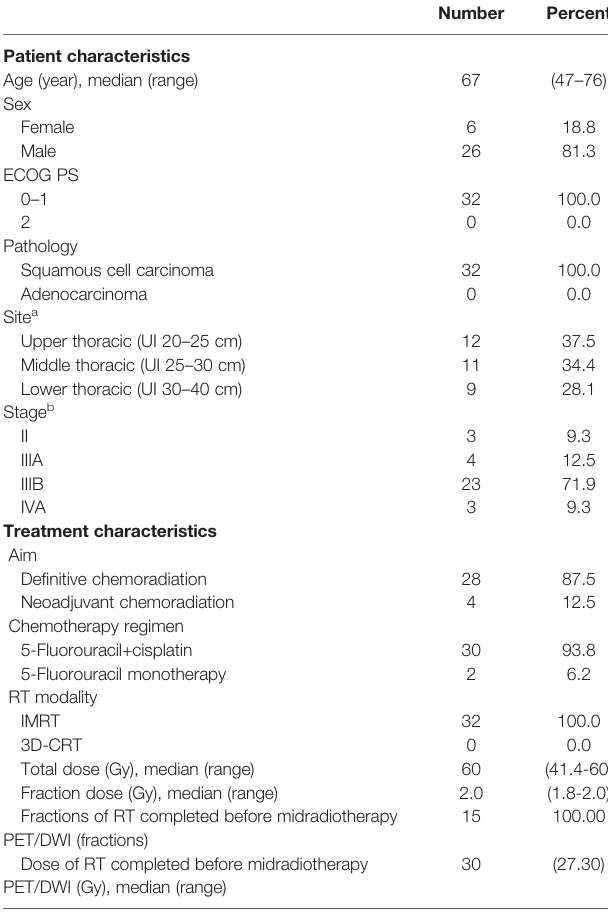
TABLE 1 | Patient and treatment